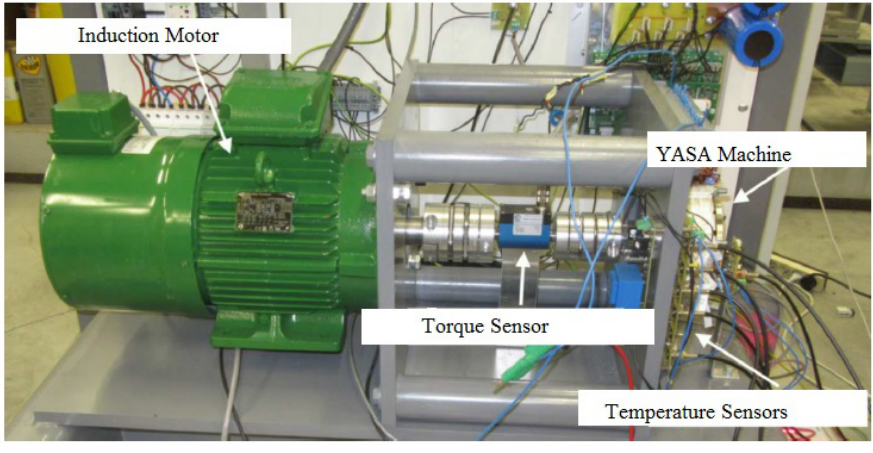
Figure 24. The experimental setup.